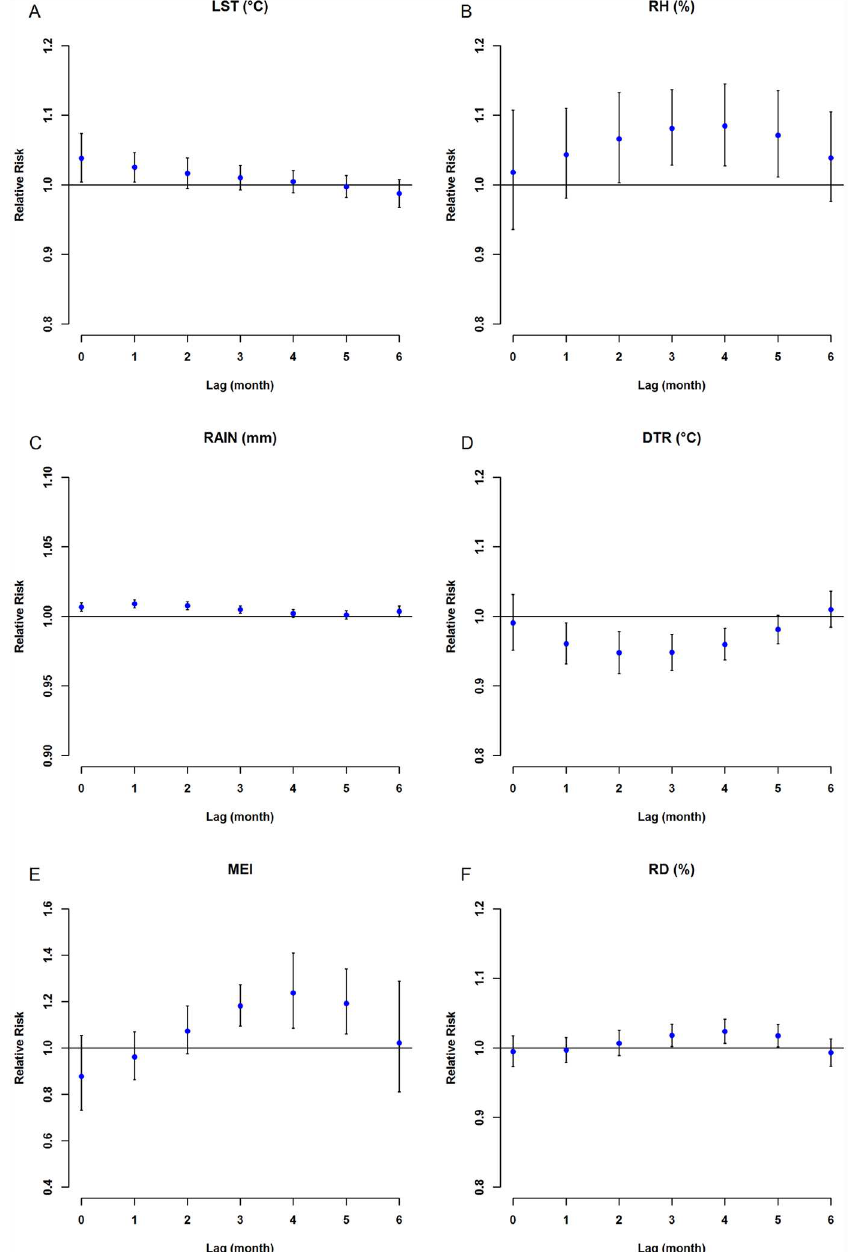
Fig 4. Lag-response between climate variables, including (A) land surfacetemperature, (B) relative humidity, (C) rainfall, and (D) diurnal temperature range and scrub typhus incidence over an 83-day period. The red lines are mean relative risks, and gray regionsare 95%